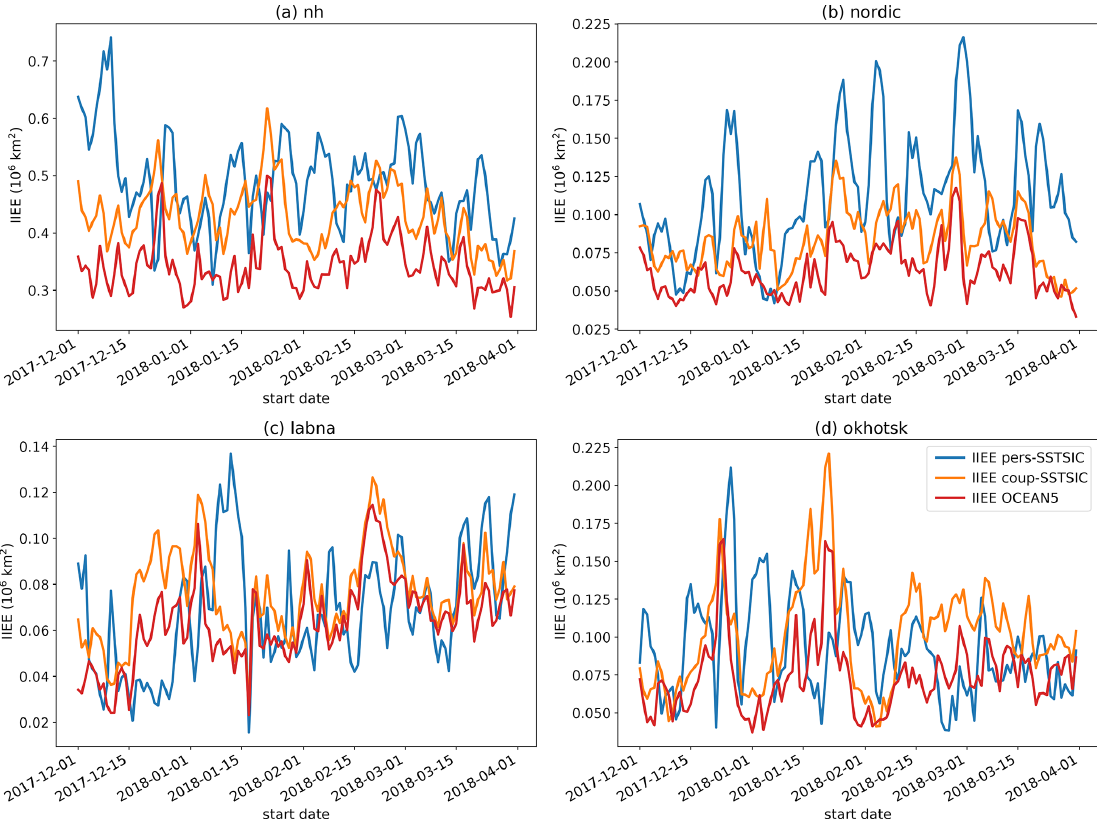
Figure 5. Time series of day-3 integrated ice edge error (IIEE) of all forecasts for the whole Northern Hemisphere (a) , the Nordic Seas (b) , and the Labrador–North-East Atlantic (c) and the Sea of Okhotsk (d) regions. These regions are shown in Fig. 1c and f. The date is given in the format